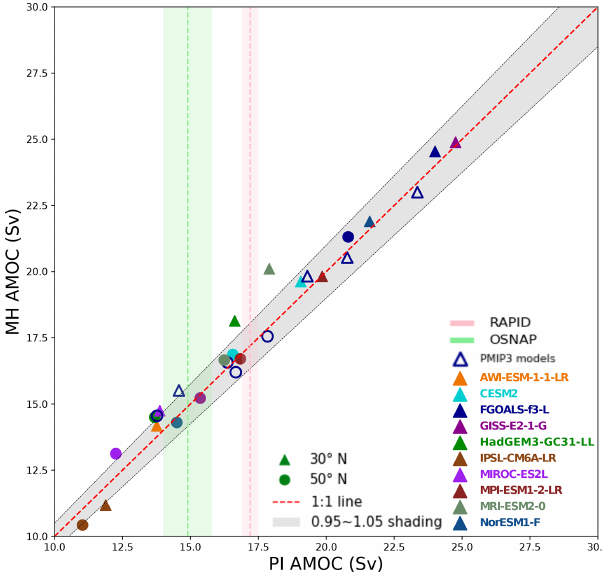
Figure 9. Atlantic Meridional Overturning Circulation (AMOC) in the simulations. The strength of the AMOC is defined as the maximum of the mean meridional mass overturning streamfunction below 500m at 30 and 50 ◦ N in the Atlantic. The strength in the piControl simulation provides the horizontal axis, whilst the ver- tical location is given by the strength in the midHolocene simula- tion. Data points lying on the 1:1 line demonstrate no change be- tween the two simulations. Observational estimates of the present- day AMOC strength are shown from both the RAPID-MOCHA ar- ray (at 26 ◦ N, Smeed et al., 2019) and the OSNAP section (between 53 and 60 ◦ N, Lozier et al.,